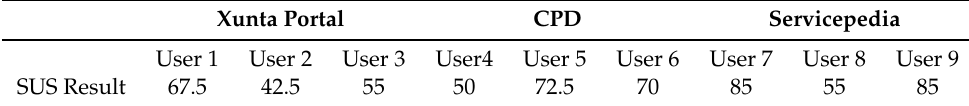
Table 3. This table shows the results of the SUS questionnaire.